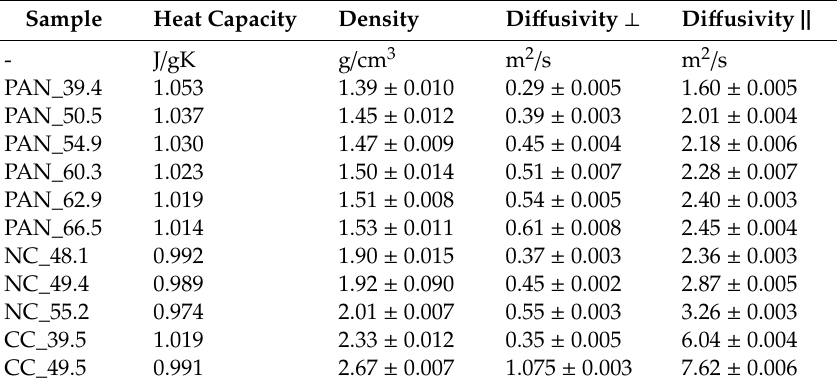
Table 2. The heat capacity, density and thermal di ff usivity of the tested samples at 20 ◦ C, the sample name consists of the fiber type and the fiber volume content.